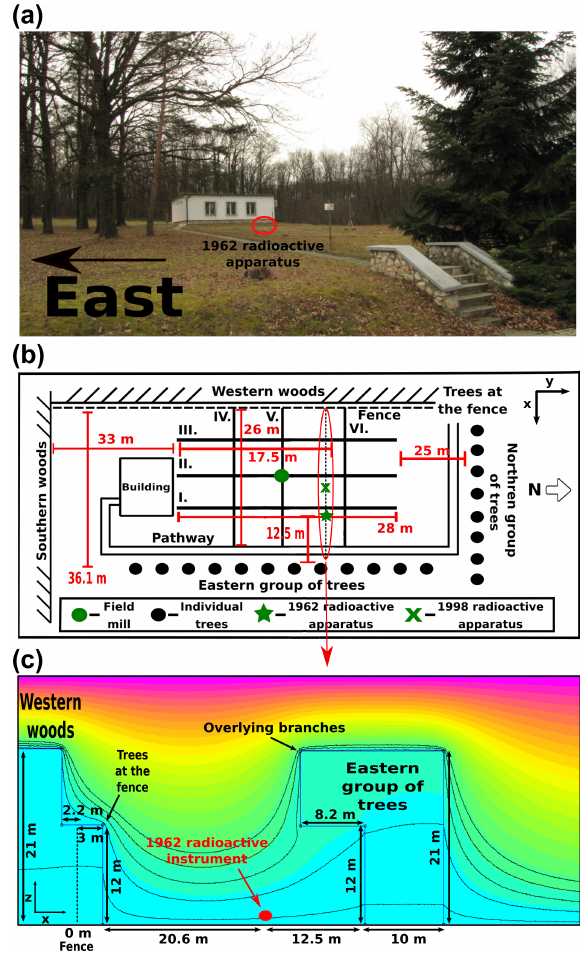
Figure 1. (a) Photo of the measurement site. (b) Schematic map of the measurement site (not to scale). “1962 radioactive appara- tus” is the older radioactive instrument (PG 62 ); “1998 radioactive apparatus” denotes the newer one (PG 98 ). (c) Sketch of the model geometry in the east–west cross section, along lines IV, V, and VI (see b ). Heights and distances correspond to the model for the year 2017. The distribution of electric potential as obtained from the model with effective tree conductivities (see Sect. 3.1) is indicated by colours. Light blue to magenta colours correspond to near zero to stronger electric potentials, respectively. Equipotential lines are drawn at 12, 50, 90, 125, and